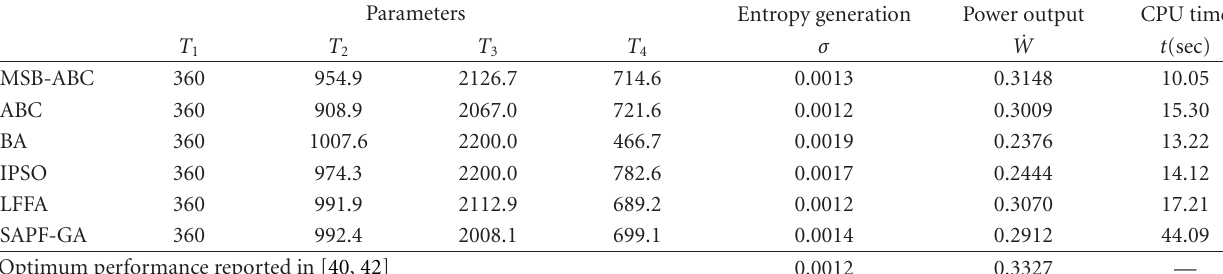
Table 2: performance of tested algorithm in γ 0 = 1 . 41 and k 1 = 0 . 00006 .